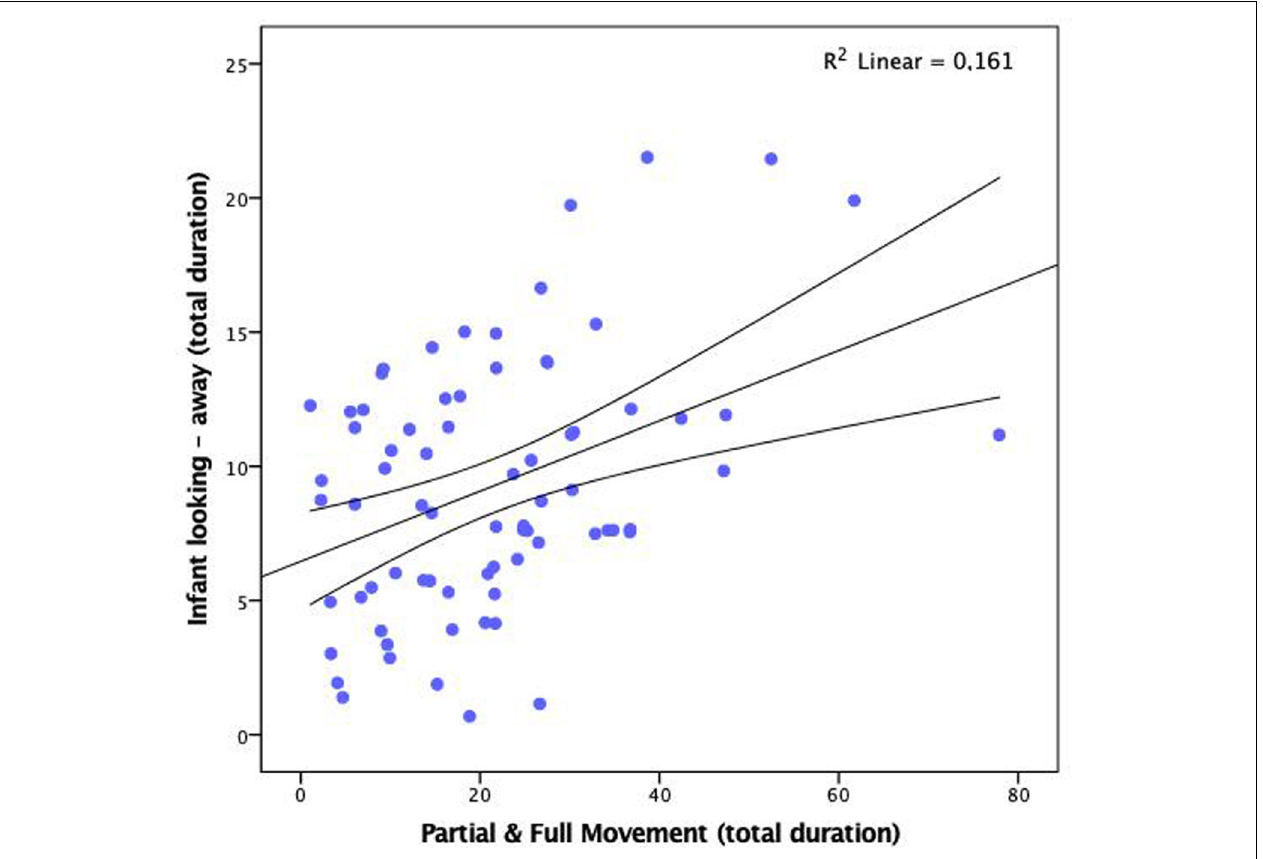
FIGURE 5 | Scatterplot showing correlation between the duration of partial and full movement and the duration of looking away from the screen (infants seated on a lap, n = 74). Duration given as percentage of total observation